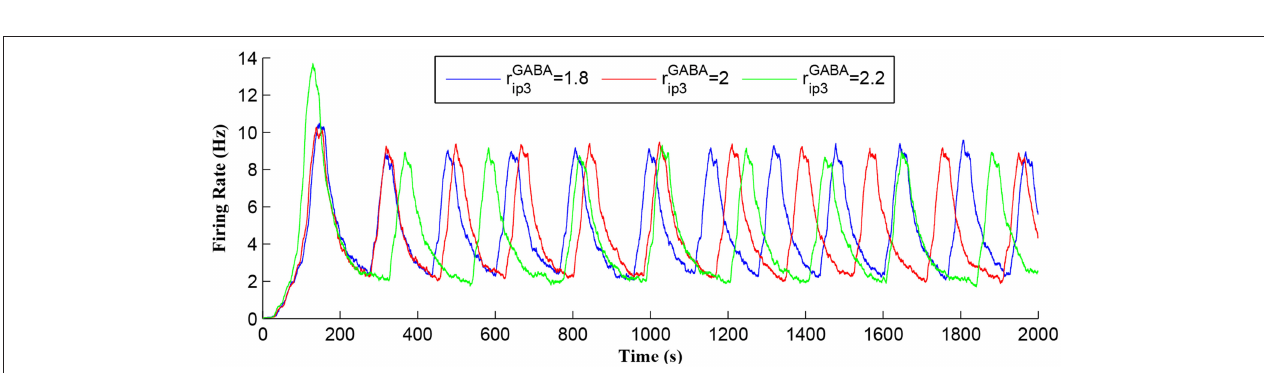
FIGURE 12 | Astrocytic Ca 2 + as a function of time with f pre of 20, 40, and 80 Hz as a parameter. Note that for the extreme cases of (20 or 80 Hz) no Ca 2 + oscillations occur: for f pre = 20 Hz T CICR can never be achieved and at 80Hz degradation of IP 3 is insufficient to allow CICR to repeatedly occur. Consequently, there is a frequency window over which oscillations can occur.